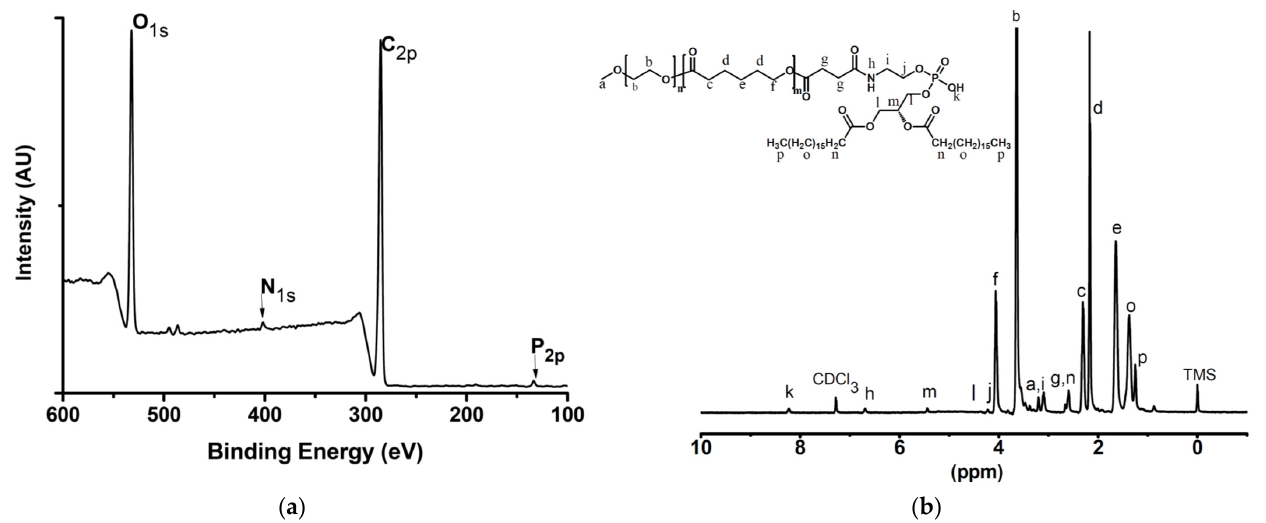
Figure 1. Spectral characterisation of a representative DSPE-terminated copolymer (PP3-DSPE). ( a ) XPS and ( b ) 1 NMR spectra.